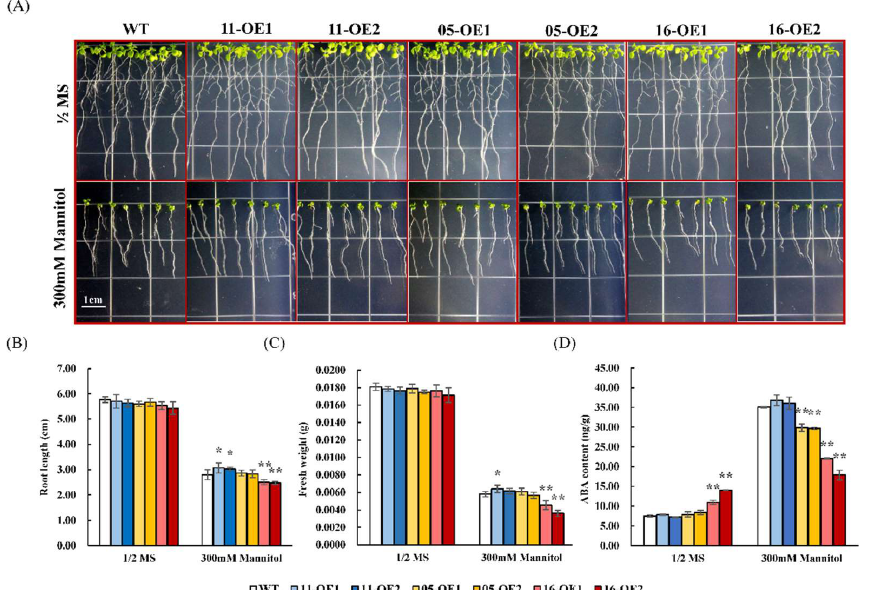
Figure 6. Analysis of drought tolerance at the seedling stage. ( A ) Morphology of WT and trans- genic seedlings growing for 7 days on half-strength MS medium with 0 or 300 mM mannitol. Bars = 1 cm. ( B – D ) Root length, fresh weight, and ABA content of WT, 11-OE1/OE2, 05-OE1/OE2, and 16-OE1/OE2 plants. For fresh weight analysis, each repeat contained the weight of three seedlings. Data are presented as means and standard deviations of three independent experiments.